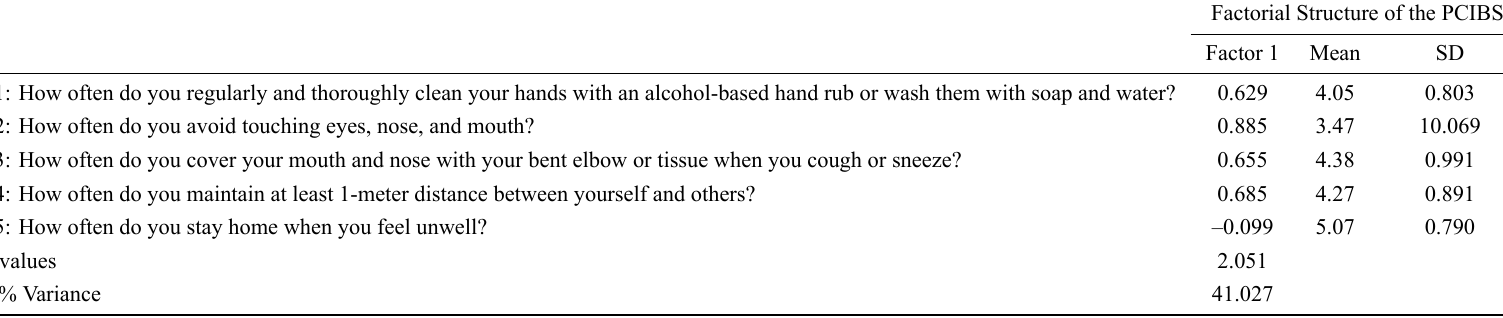
Table 2. Exploratory Factor Analysis (EFA) of the Portuguese version of the Preventive COVID-19 Infection Behaviors Scale (PCIBS) with model 2 (N =